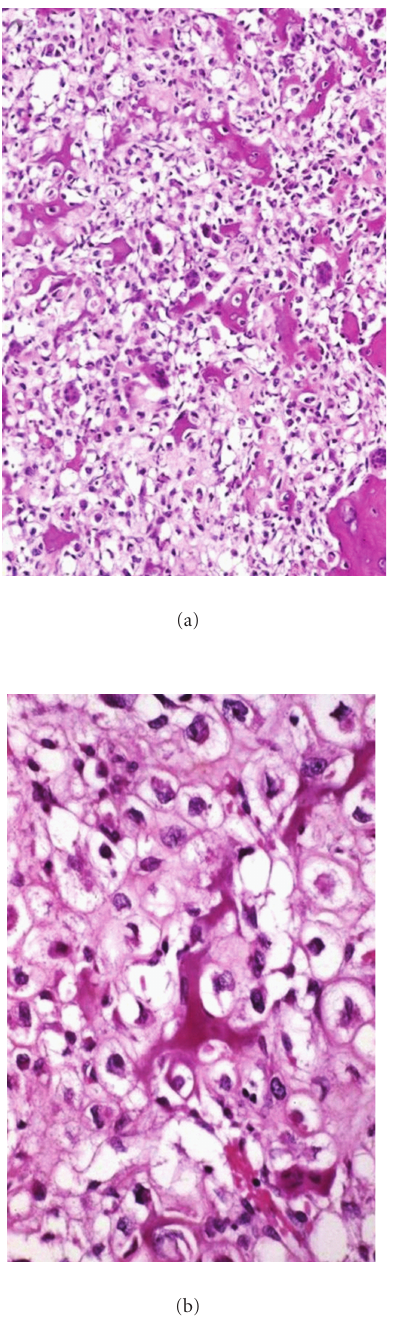
Figure 16: (a) Tumor cells with clear cytoplasm between irregular trabeculae of woven bone. (b) Higher magnification of tumor cells with abundant clear or faintly granular cytoplasm and central round nuclei containing occasional prominent